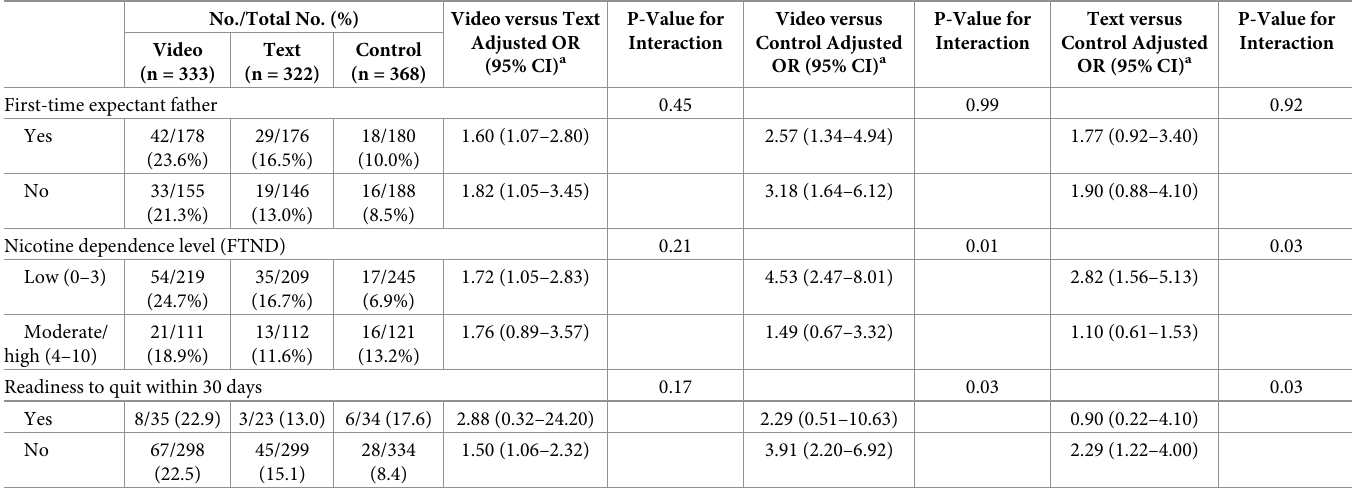
Table 4. The validated abstinence at 6 months by